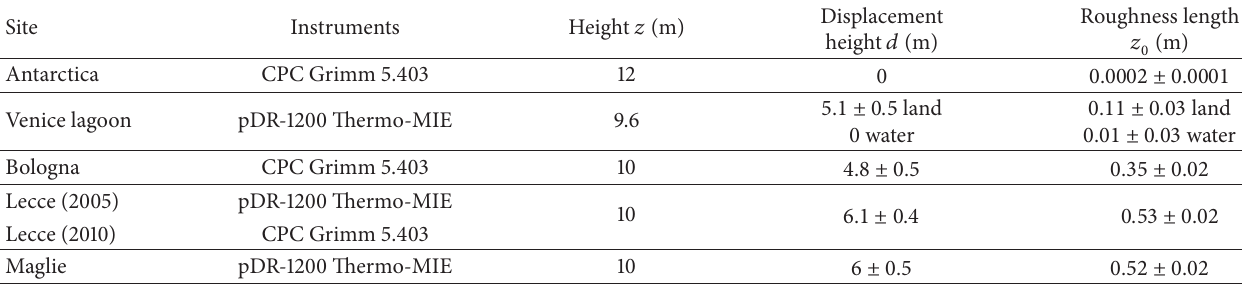
Table 1: Summary of experimental sites and instruments used in aerosol sampling. The table includes the details of the set-up, such as measurement height ( 𝑧 ), displacement height ( 𝑑 ), and roughness length ( 𝑧 0 ).